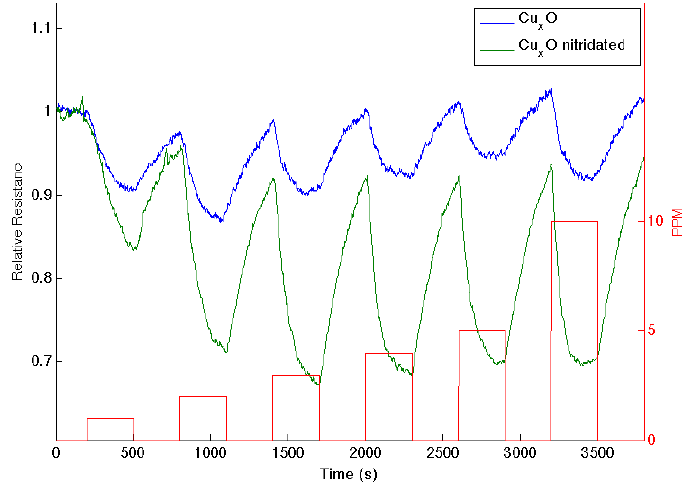
Figure 5. Response of a Cu O-treated PS interface to NO ( blue line ) and after nitridation x with triethylamine ( green line ). The boxes ( red line ) denote the analyte concentration from 1 to 10